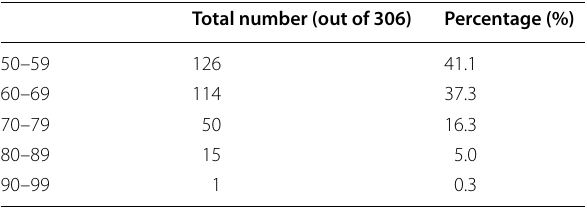
Table 3 Comorbidities/risk factors of the cohort